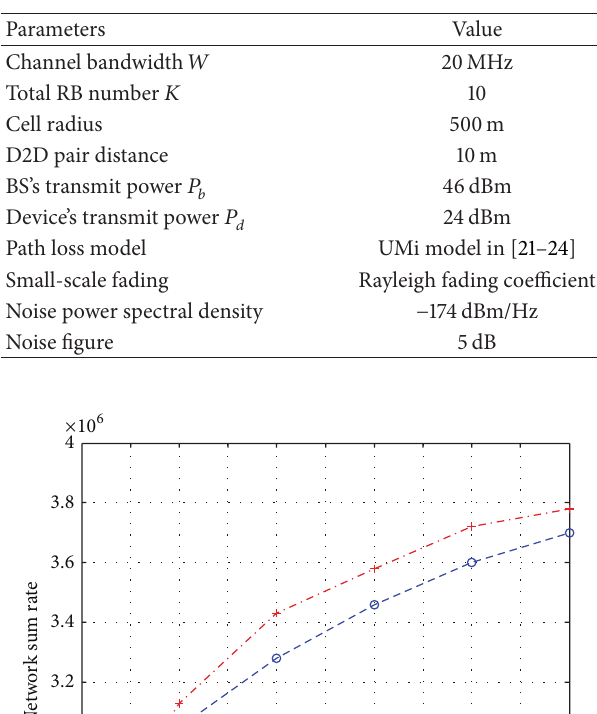
Table 1: Simulation parameters.